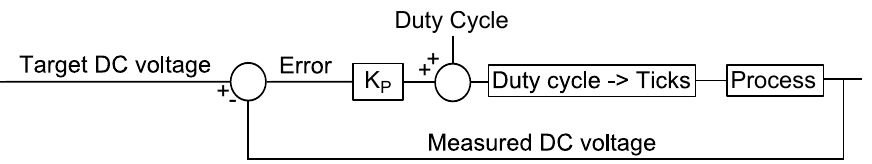
Figure 5. Open loop controller of the DC load duty cycle.